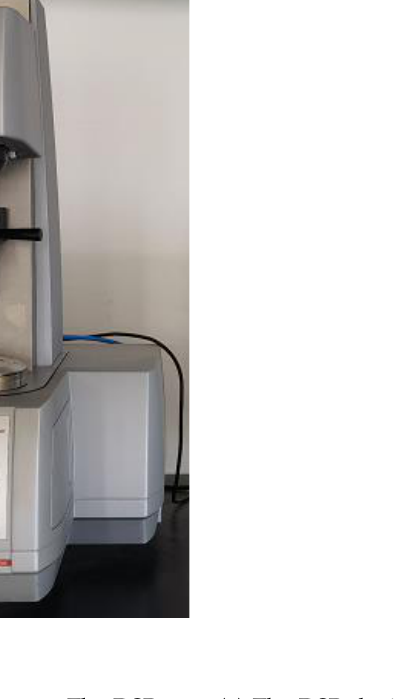
Figure 2. The DSR test: ( a ) The DSR device; ( b ) A sample with 25 mm dia.; ( c ) A sample with 8 mm dia.